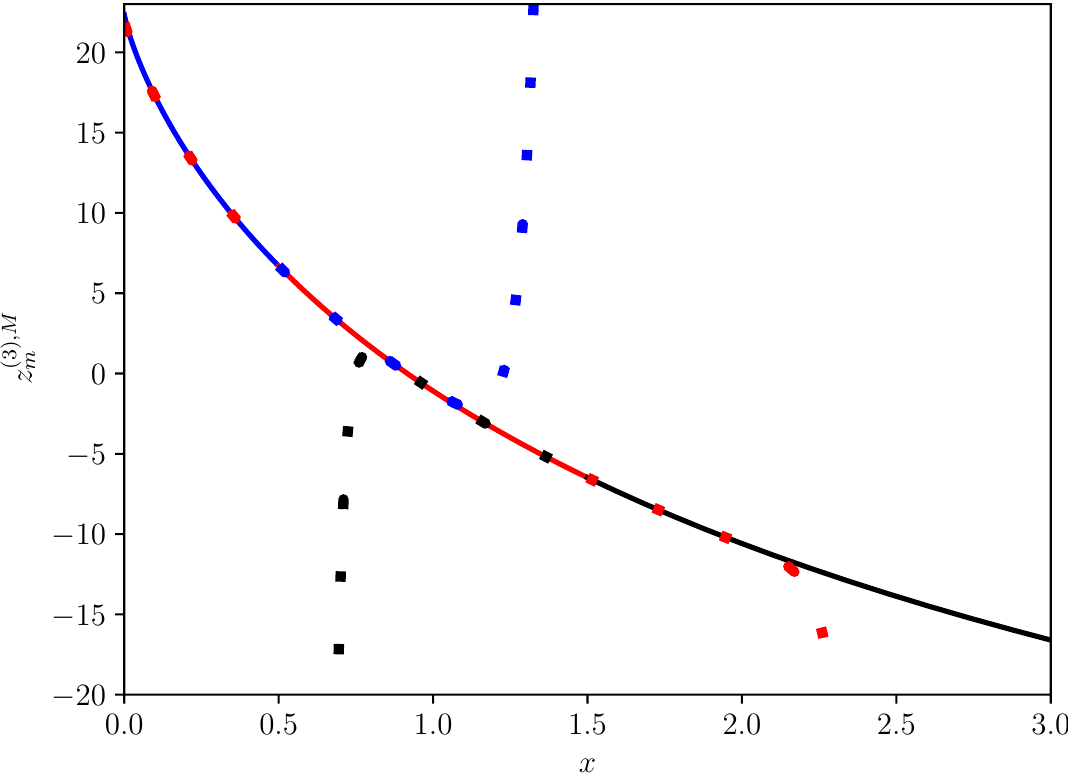
Figure 3. z (3) m as a function of x . The expansions for x ! 0, x ! 1 and x ! 1 are shown as solid lines in the regions where the respective expansion is used for the numerical evaluation of z m in the supplementary material. Outside this region dotted lines are